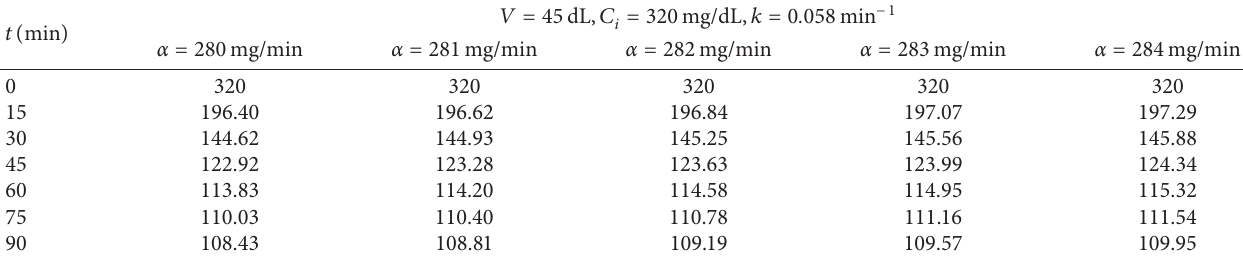
Table 5: Blood glucose concentration C ( t ) for different values of the rate of infusion α and time t with � 320mg/dL , and k � 0 . 058 min − 1 , see Figure 3. V � 45dL ,C i